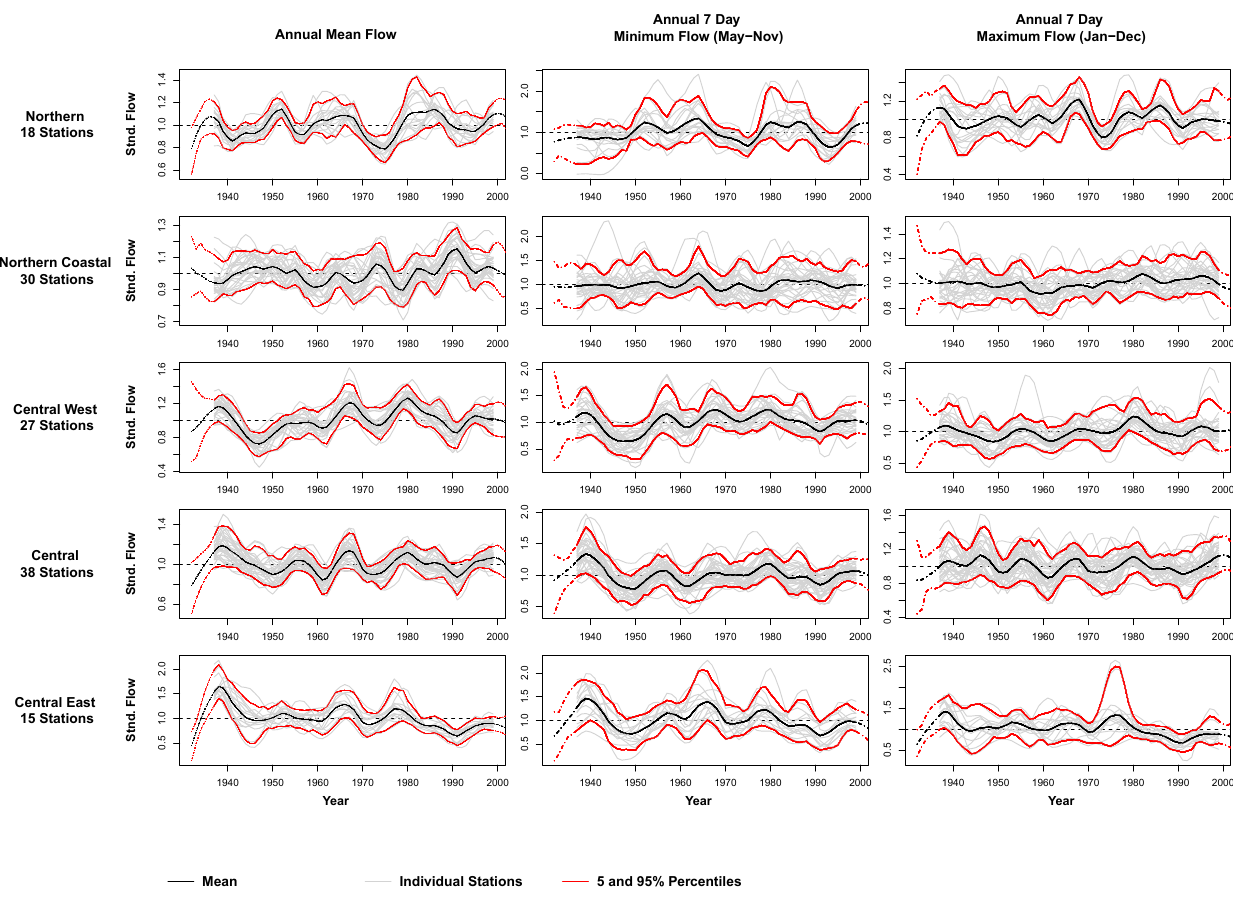
Fig. 3. Interdecadal variability derived using LOESS smoothing. Grey lines show individual station STD SM series, black line shows RA STD SM series. Red lines show the 5th and 95th percentiles of the combined STD SM